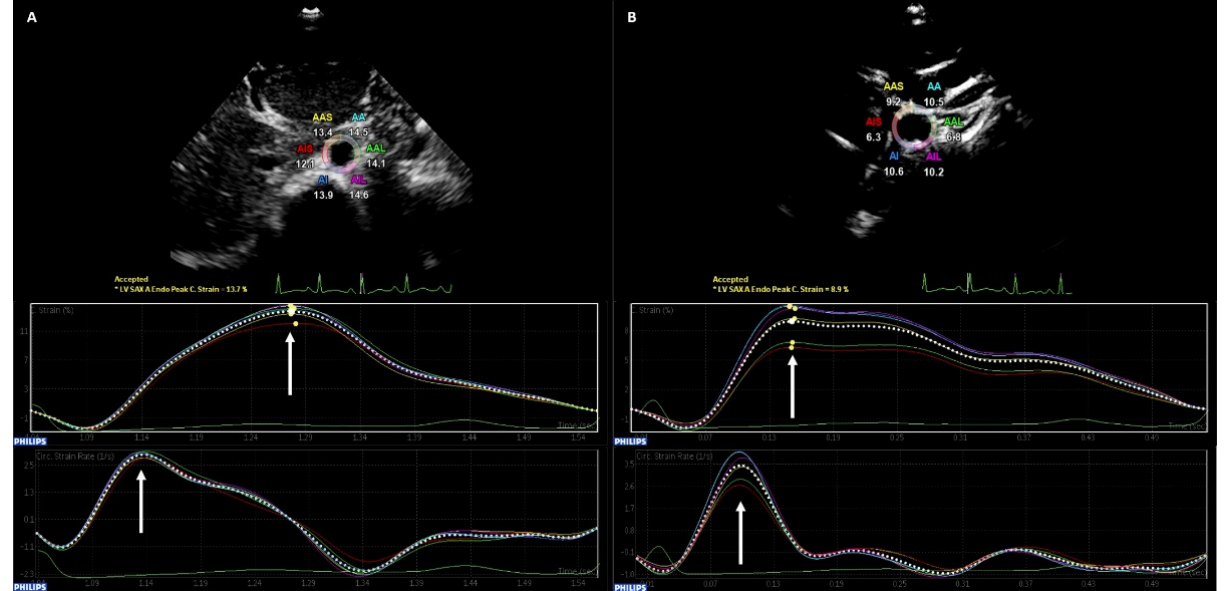
Figure 1. Two-Dimensional Speckle Tracking (2DST) of the Abdominal Aorta and the Common Carotid Arteries. 2DST tracks pixels of the region of interest (ROI) over the cardiac cycle and quantifies their deformation in percent. Special care was taken to set the ROI as small as possible to precisely track the vessel’s wall. Peak circumferential strain (upper graph, marked with the arrow, %) and peak strain rate (lower graph, marked with the arrow, 1/s) were identified manually. ( A ) The abdominal aorta (AAO) was evaluated in short subxiphoid view at epigastric level under three-lead ECG tracking. ( B ) Both common carotid arteries (CCA) were recorded under three-lead ECG tracking in supine position. The neck extended up to a 45 ◦ angle and turned to the opposite side of examination.